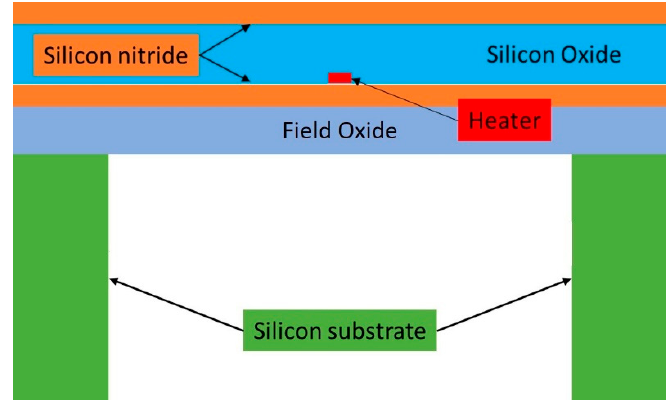
Figure 1. Schematic representation of the CMOS technology in this work, with highlighted all the layers (not in scale).